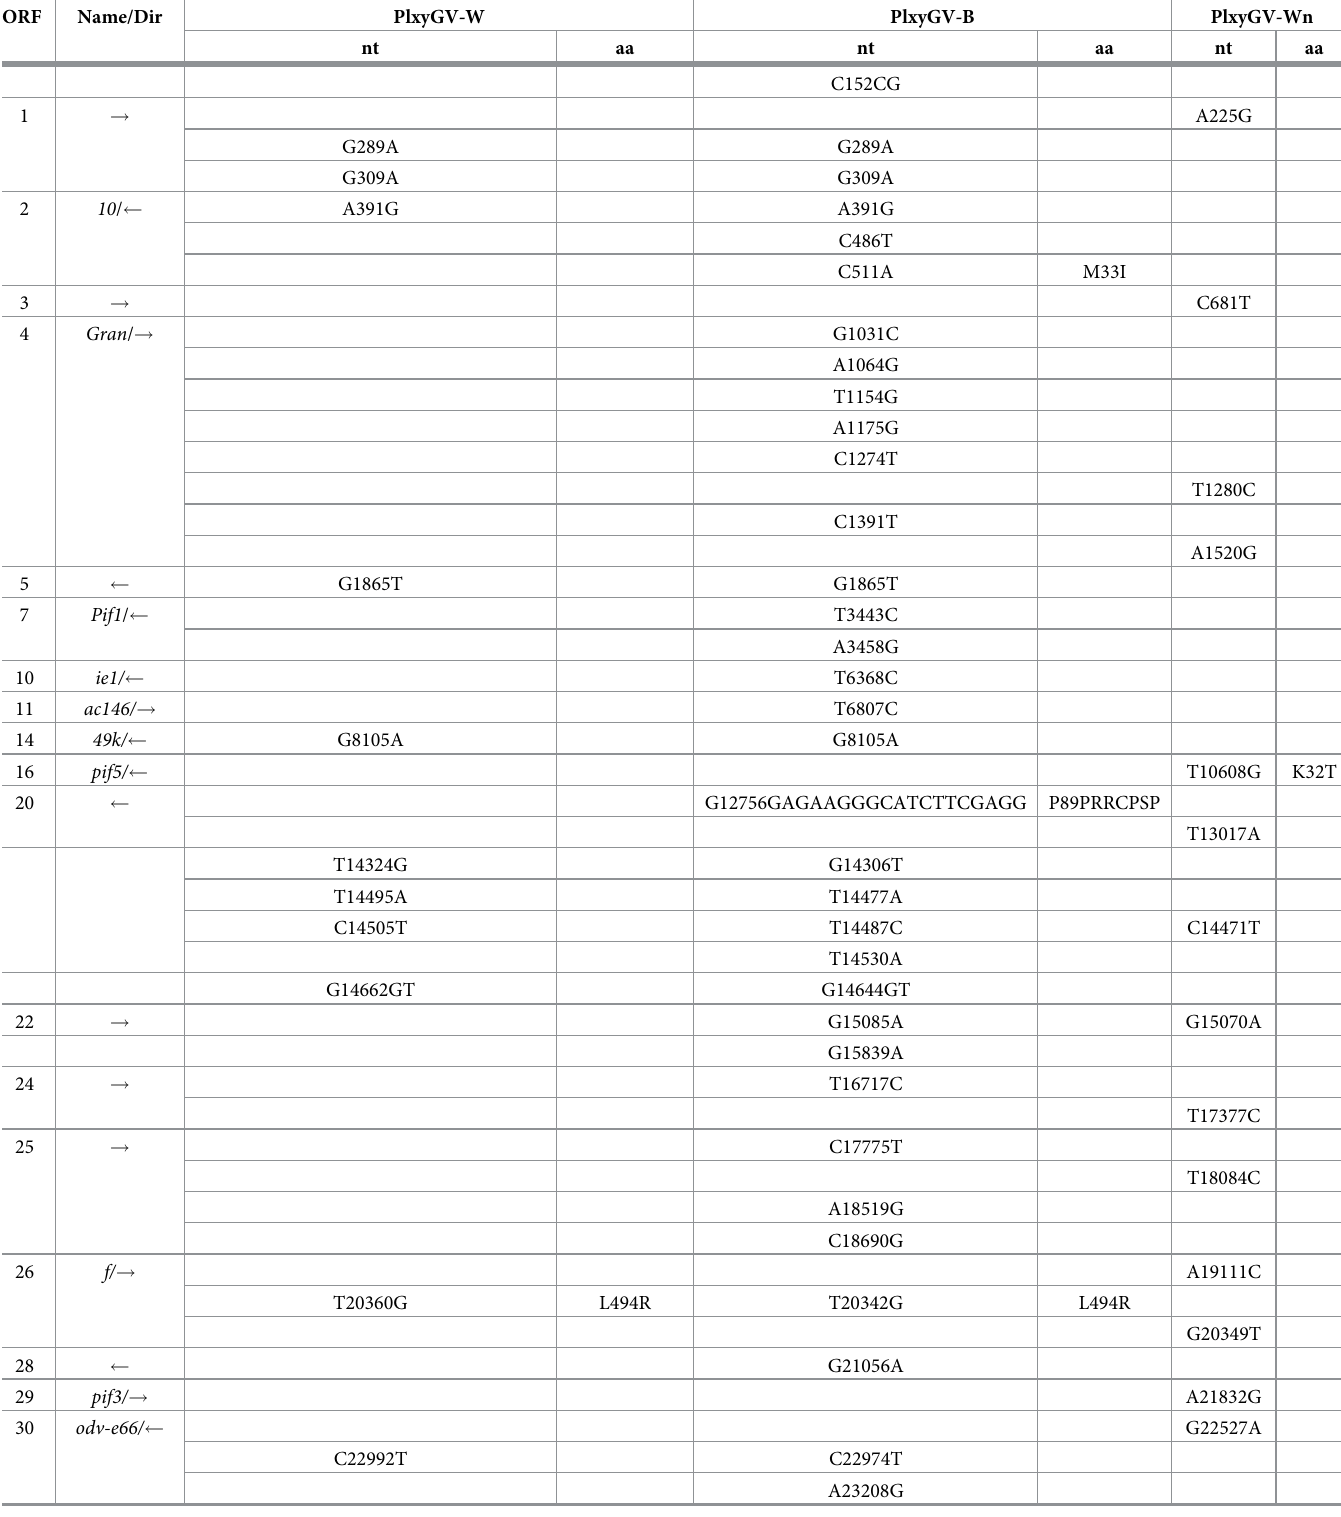
Table 1. Intra-isolate nucleotide polymorphisms in PlxyGV-W, PlxyGV-B and